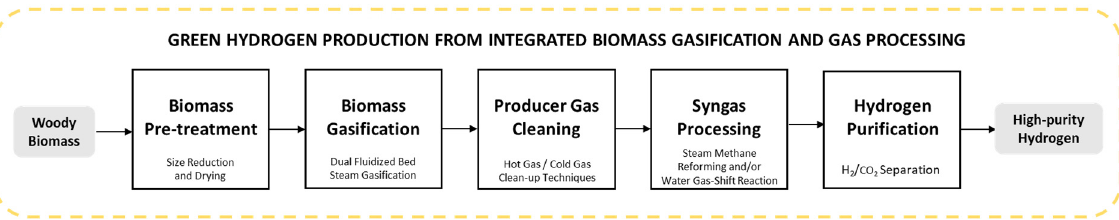
Figure 3. General process flow of integrated biomass gasification with gas processing for hydrogen